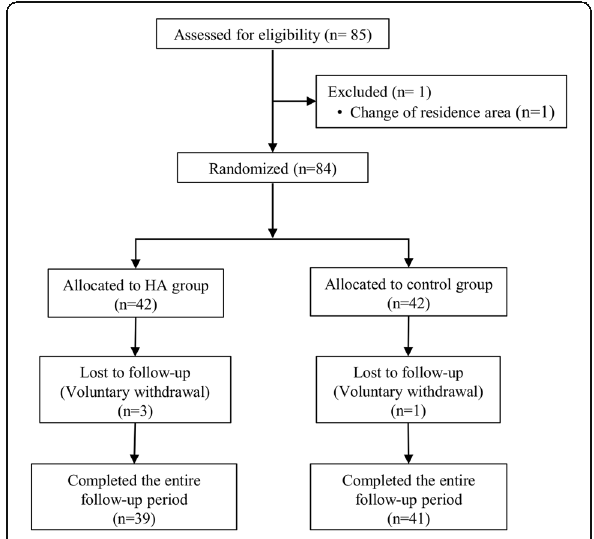
Fig. 1 Flow diagram of the patients included in the